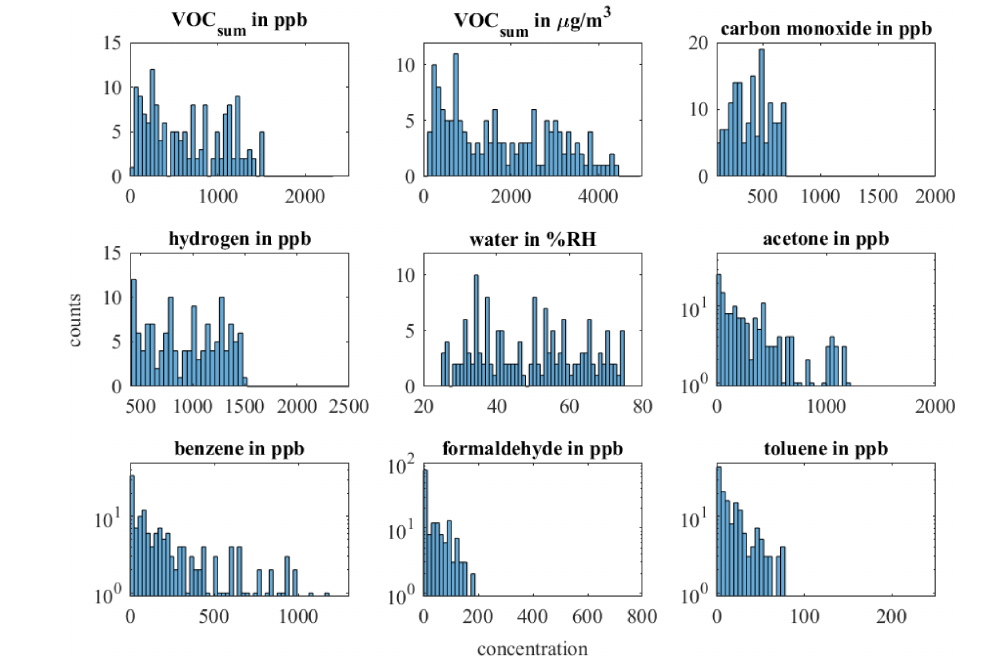
Figure A2. Concentration histogram of the observations for the reduced dataset (comparison between the randomized and sequential mea- surement) for all gases and VOC sum